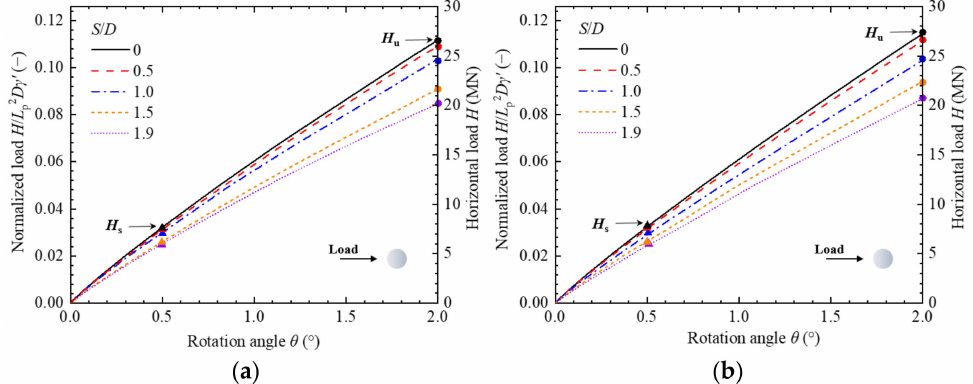
Figure 12. Load–displacement curves with different scour depths: ( a ) regular monopiles (RP);